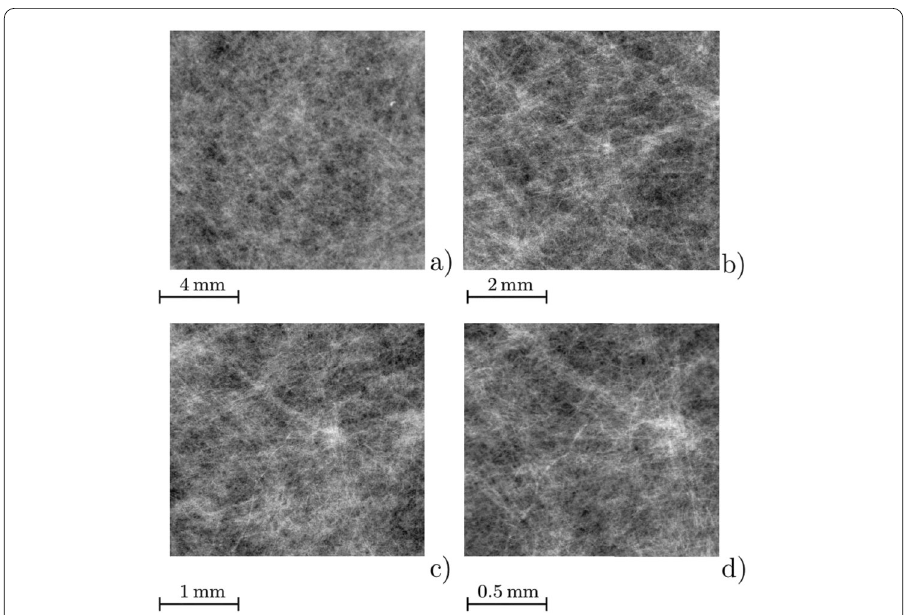
Figure 7 Pixelwise mean of the normalized local grammages of the nonwoven FL1 for four lateral resolutions. The images consist of 2048 × 2048 pixels: a) pixel size 6.734 μ m, b) pixel size 3.367 μ m, c) pixel size 1.684 μ m,